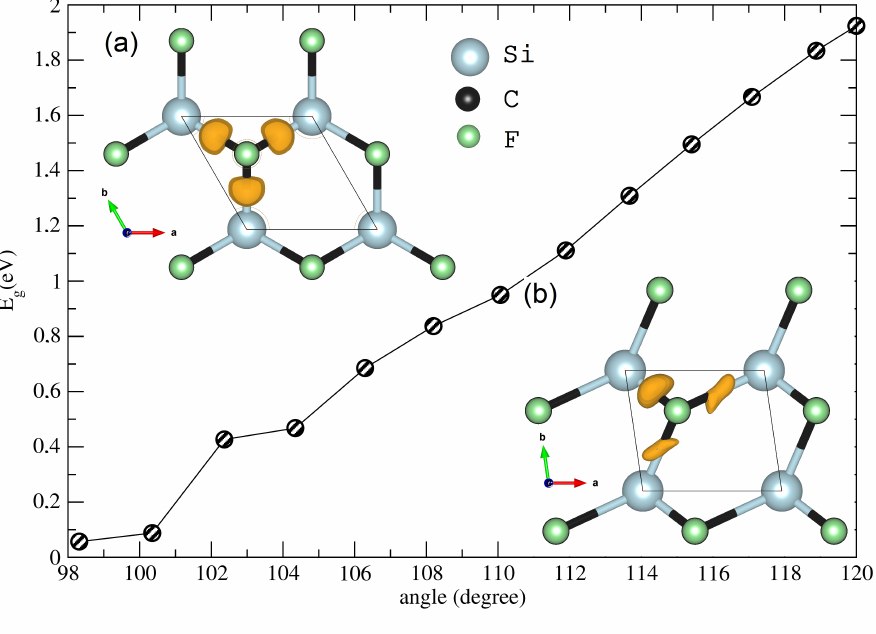
Figure 5. Evolution of the band gap as a function of gamma angle. The inset shows the 3D-ELF isosurface of the structure at ( a ) (unstrained) 0% and ( b ) (strained) 18% of the tensile